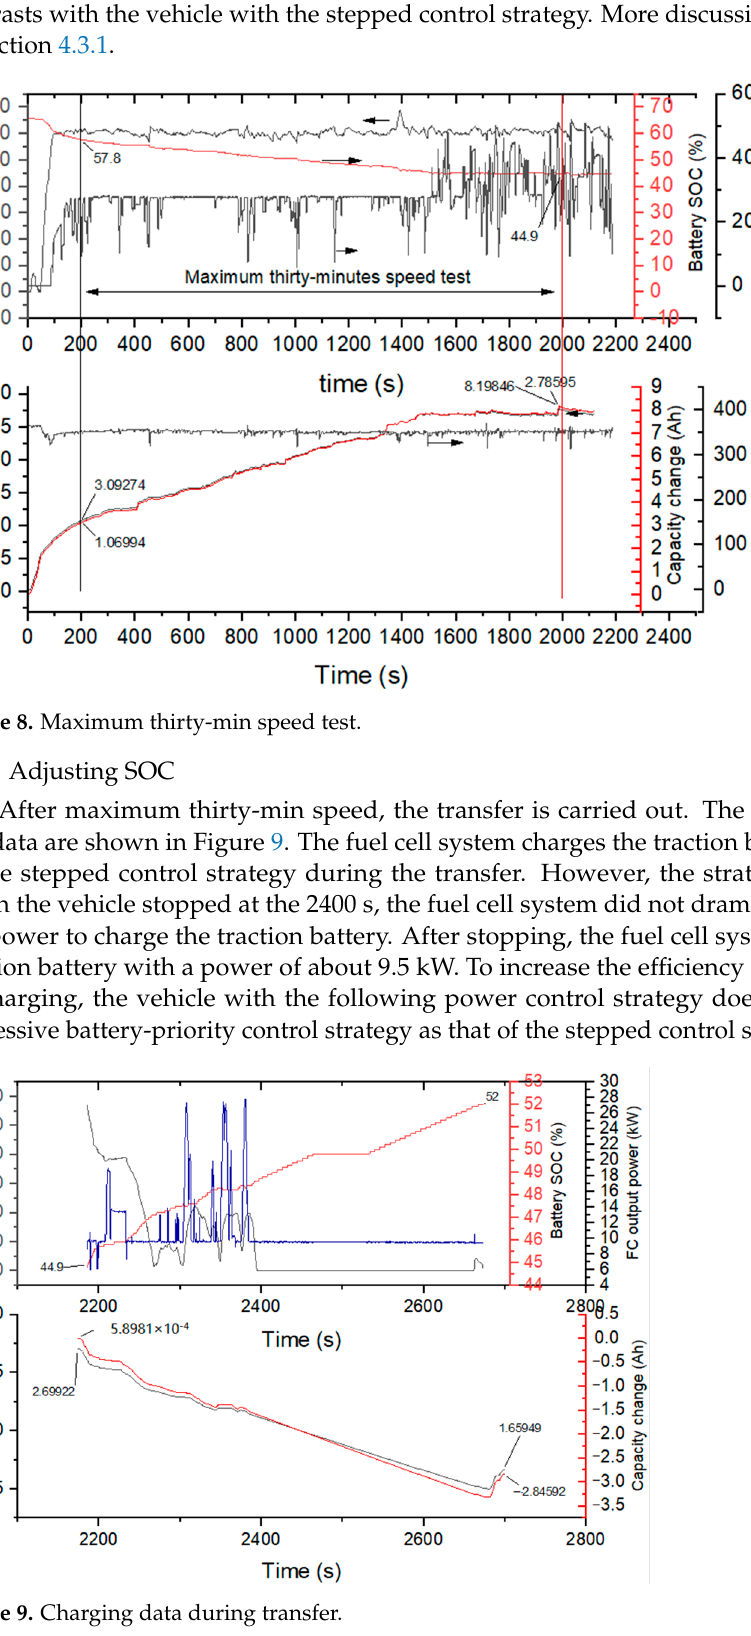
Figure 9. Charging data during transfer.